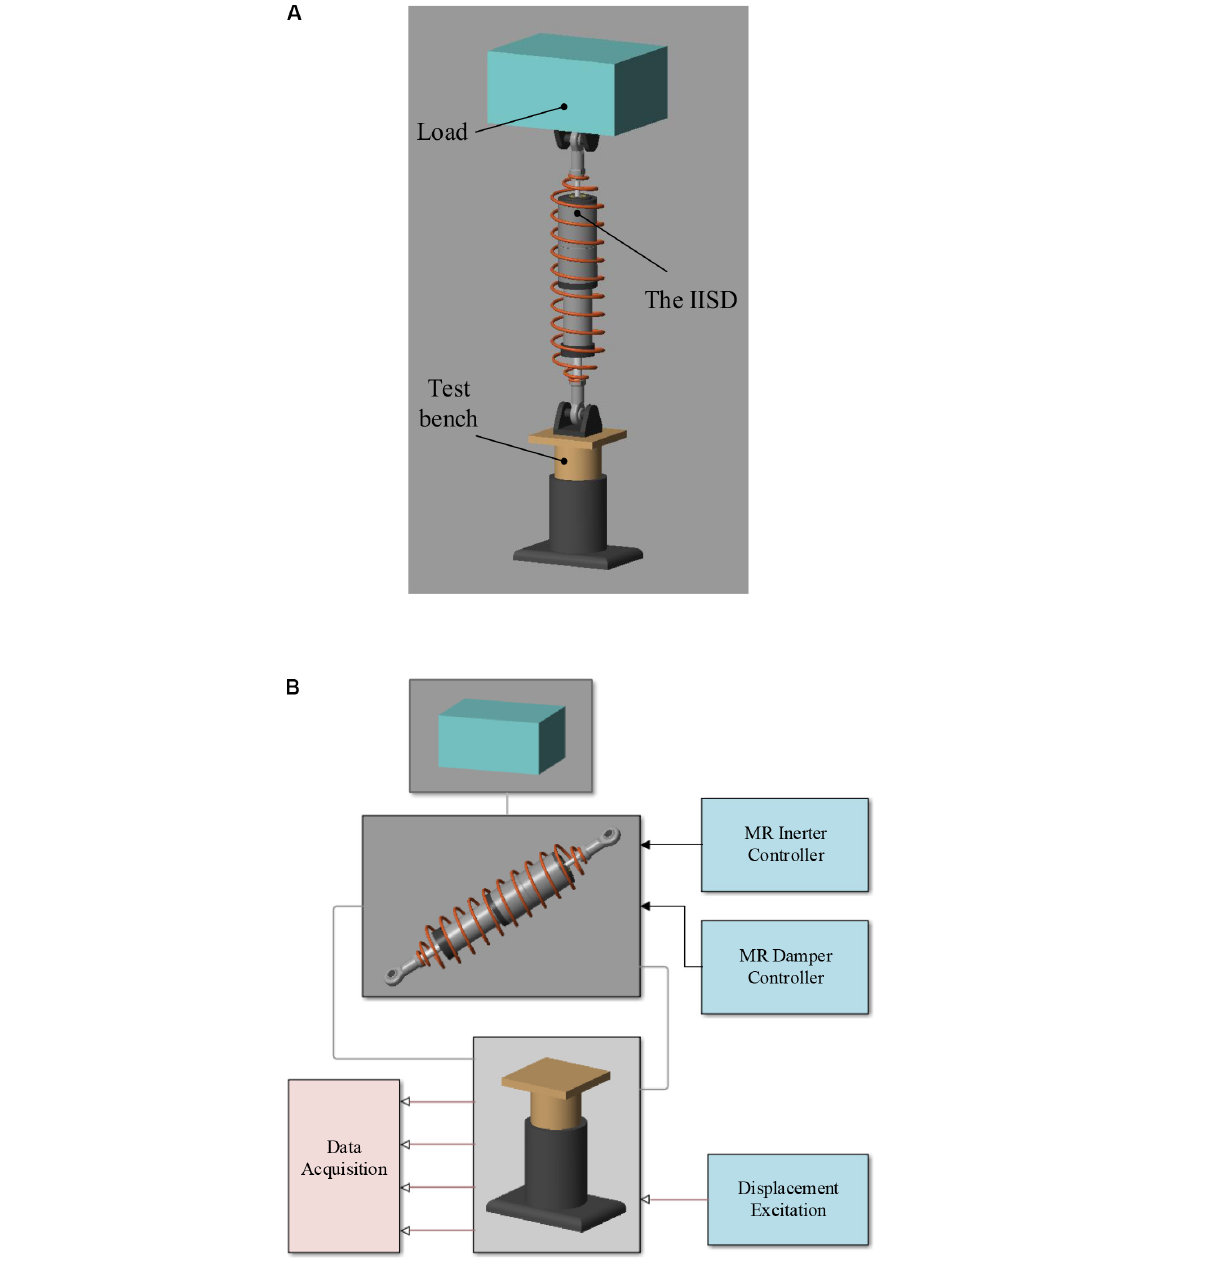
FIGURE A1 | MATLAB/SimMechanics model of the 1/4 vehicle suspension: (A) three-dimensional model and (B) Simulink model.